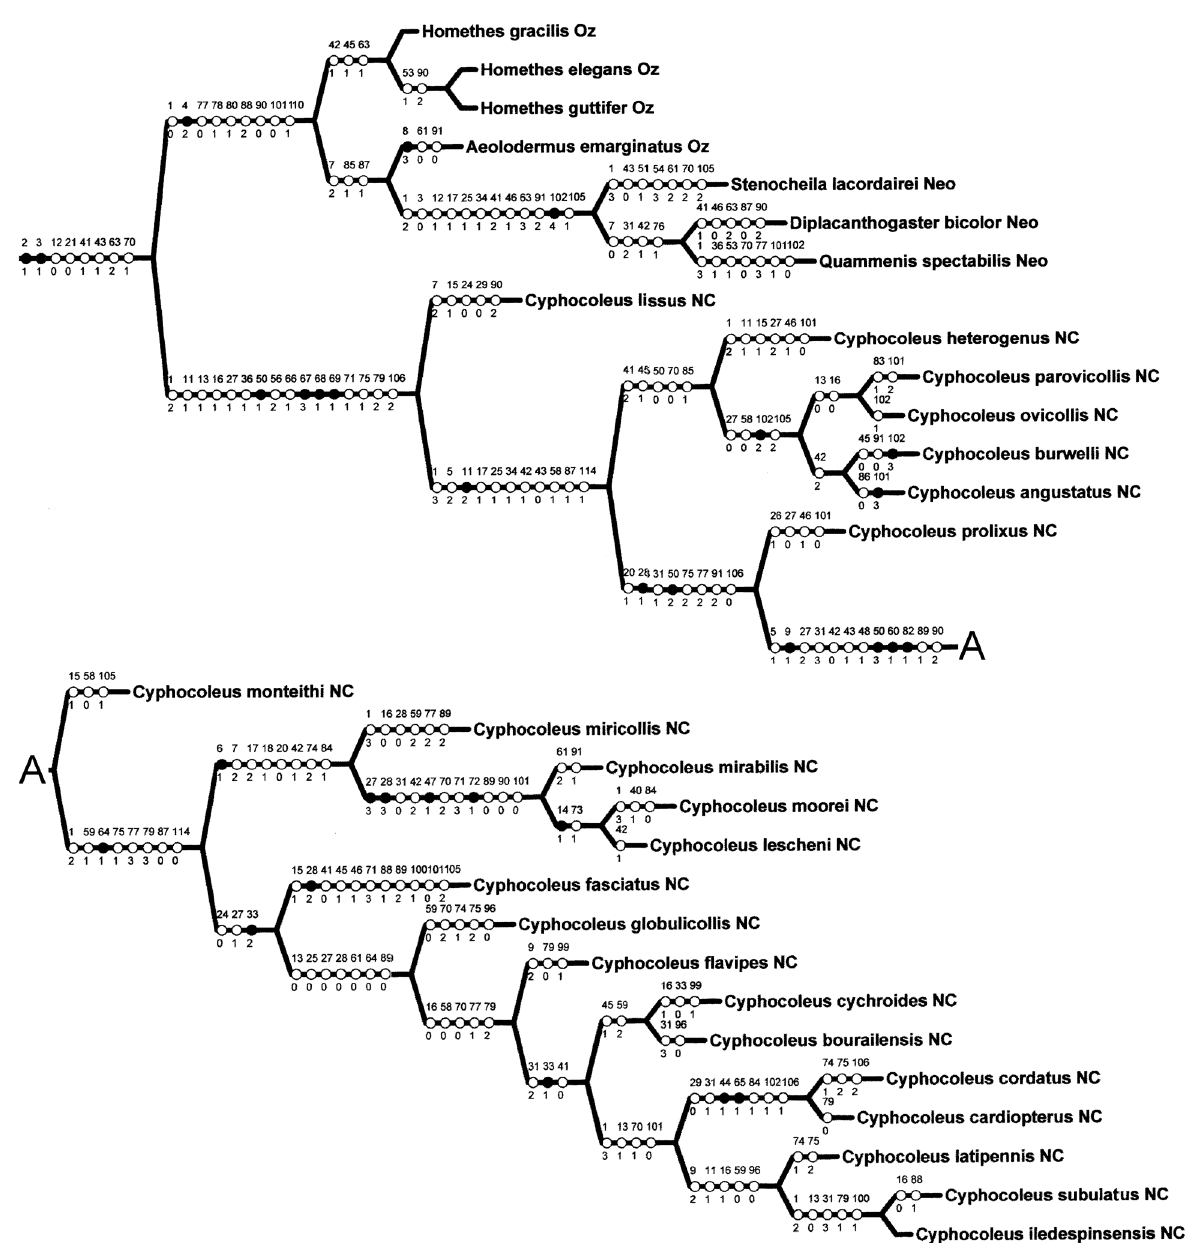
Figure 46. Parsimony cladogram of subtribe Homethina with characters indicated; character numbers above cladogram stems, state numbers below stems [cladogram divided into two parts joined at “A”]; geographic abbreviations as in Figs 44–45. in homethine taxa with broad elytra (Figs